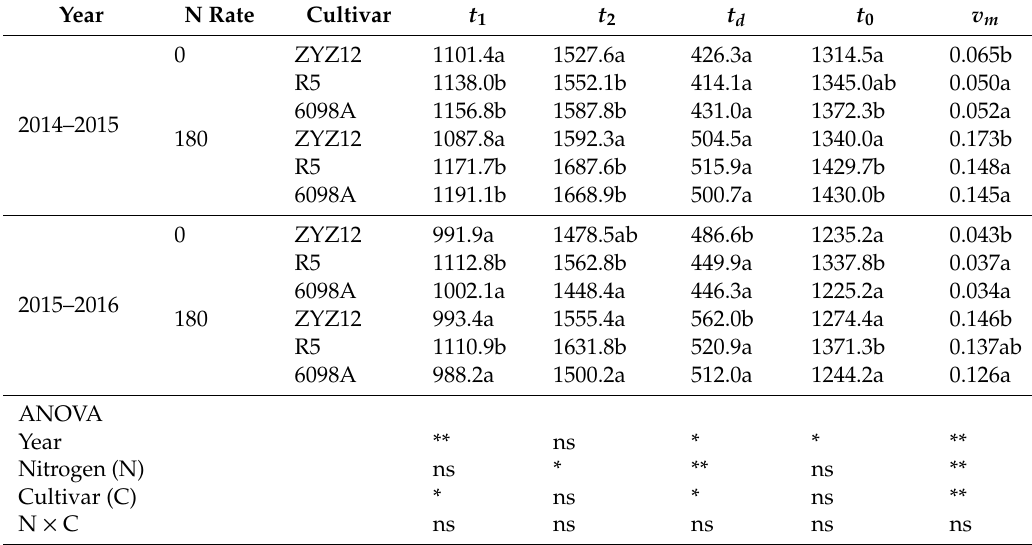
Table 3. N accumulation dynamic parameters of the oilseed rape cultivars grown at two N rates during the experimental seasons. Values with di ff erent letters are significantly di ff erent at a probability level of p < 0.05 within each N rate in the same season. t 1 and t 2 , the initial and terminal points of the rapid growth period; t d , the duration of the rapid growth period; t 0 , the point at which the maximum growth rate occurs and V m , the maximum growth rate. *, p < 0.05; **, p <